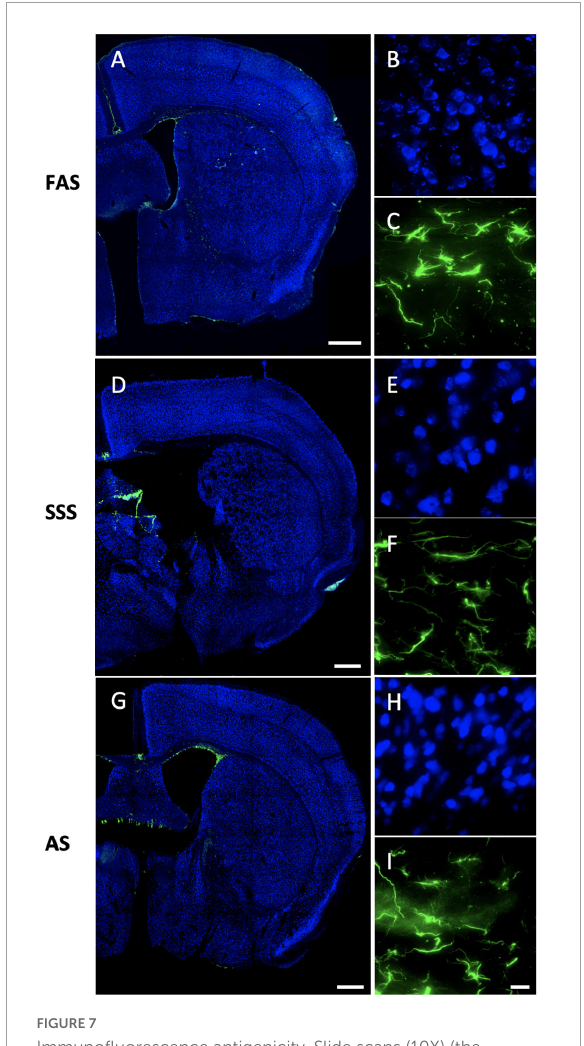
FIGURE7 Immunofluorescence antigenicity. Slide scans (10X) (the remaining closest slices of figure 33 (0.22 mm posterior to bregma of the Mouse Brain Atlas, Paxinos, 2001) of double immunostaining of NeuN (Alexa-488 showed in fake color blue) and GFAP (Alexa-555 showed in fake color green) labeled in slices of (A) FAS-fixed brain, (D) SSS-fixed brain, and (G) AS-fixed brain. Scale bars = 500 µ m. Photomicrographs (60X) of NeuN in the layers 2–3 of the secondary motor cortex (blue) for (B) FAS, (E) SSS, and (H) AS-fixed brains. Photomicrographs (60X) of GFAP in the external capsule (green) for (C) FAS, (F) SSS, and (I) AS. Scale bar = 15 µ m [valid for (B,C,E,F,H, I) ].